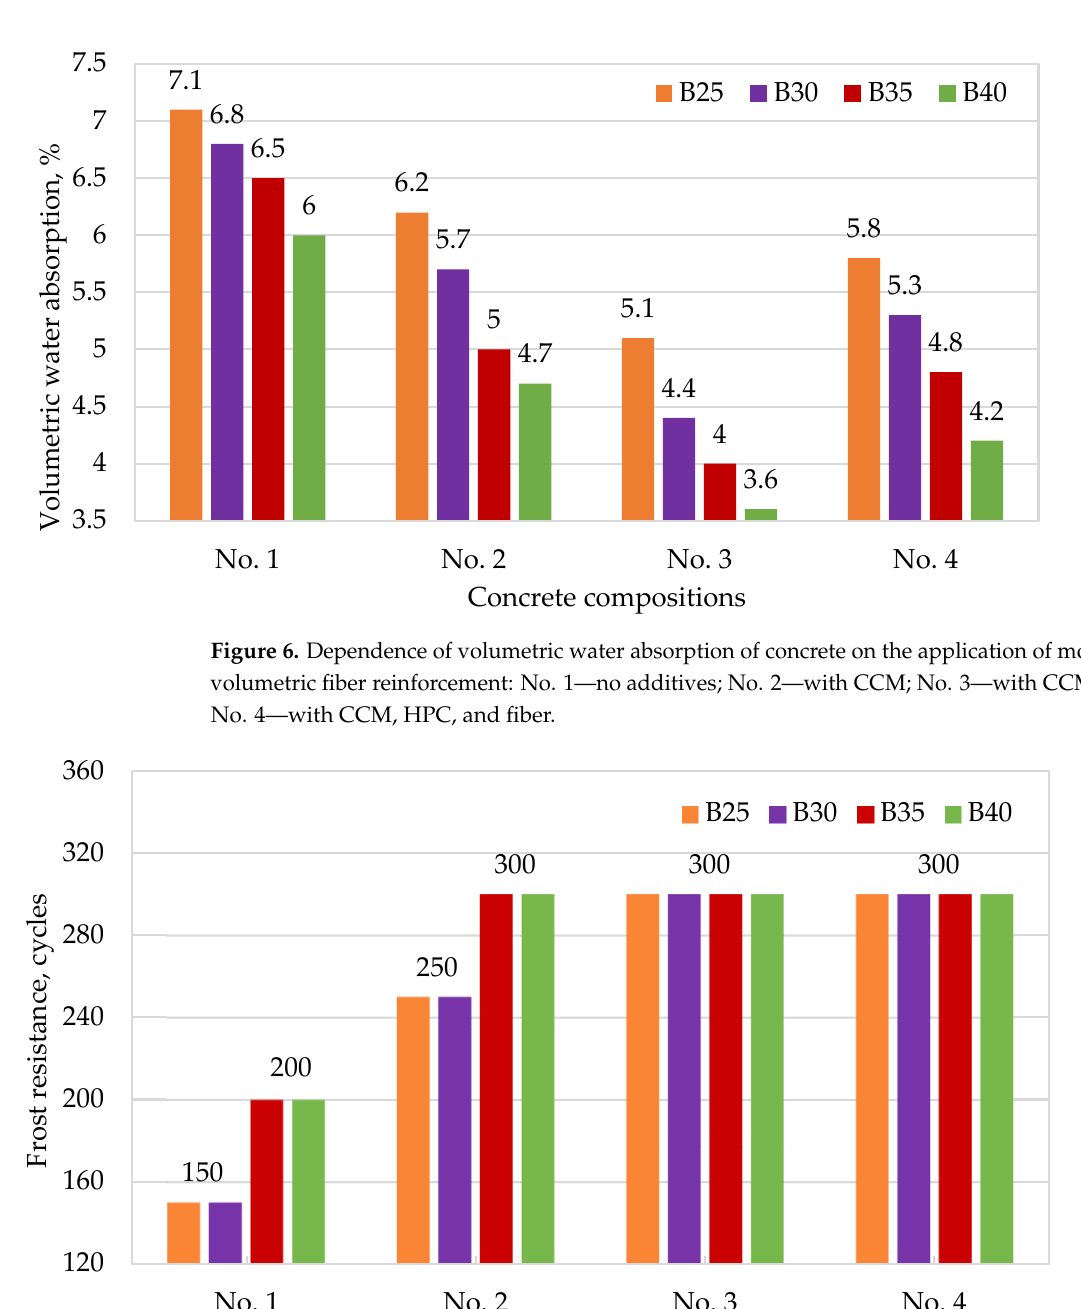
Figure 7. Dependence of concrete frost resistance on the application of modifiers and volumetric fiber reinforcement: No. 1—no additives; No. 2—with CCM; No. 3—with CCM and HPC; No. 4—with CCM, HPC, and fiber.